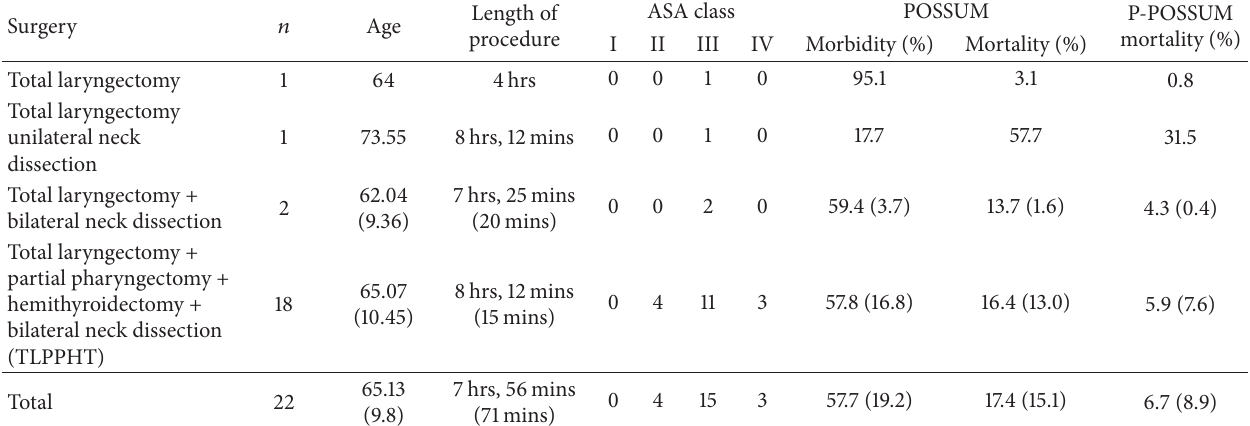
Table 2: Mean age, length of procedure, ASA class, and POSSUM scores in relation to operative procedure (standard deviation).